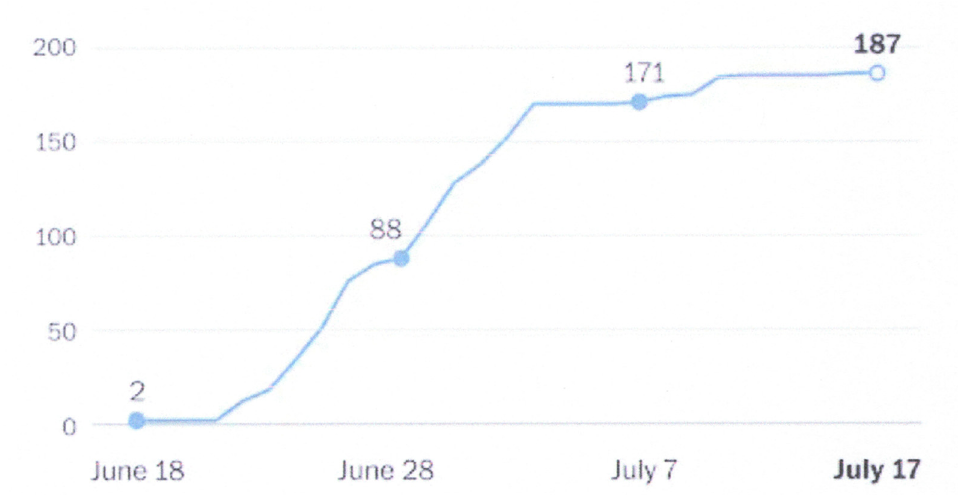
Figure 1. Example of COVID-19 cluster outbreak in Lansing, Michigan at a restaurant and pub by a few infected superspreaders (Source: Ingham County Health Department).